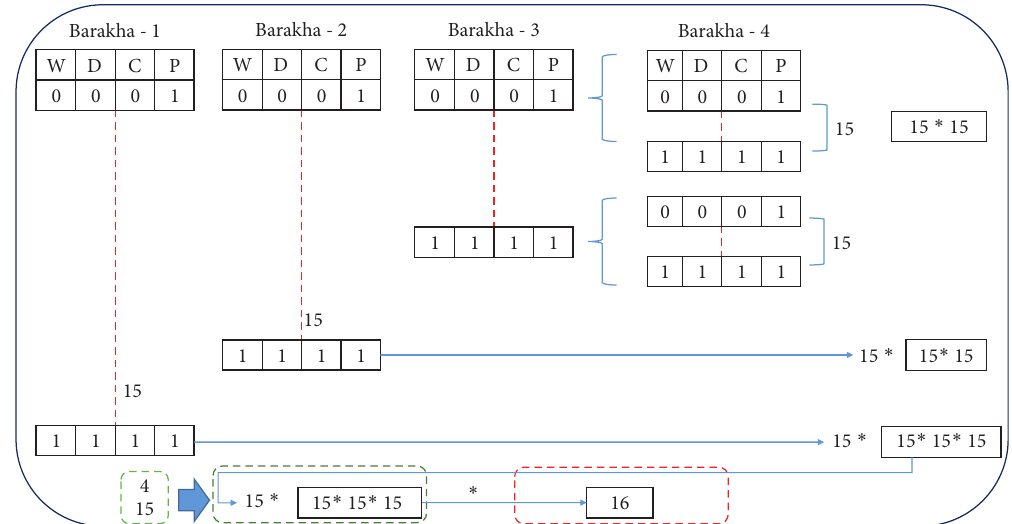
Figure 7: In-house MATLAB schematic tool for generating the switching operation-mode probability matrix.